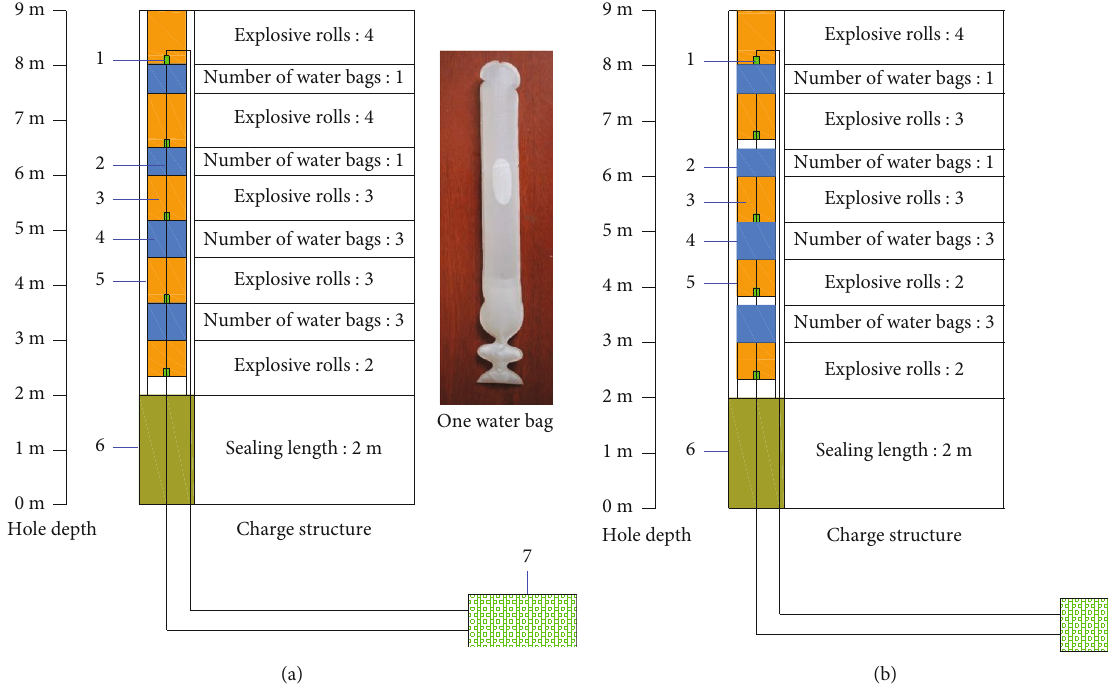
Figure 6: Charge structure of SCHB: (a) charge volume: 4.8kg and (b) charge volume: 4.2kg (1: detonator; 2: connecting wire; 3: explosive; 4: water; 5: directional slit tube; 6: sealing mud; 7: detonating